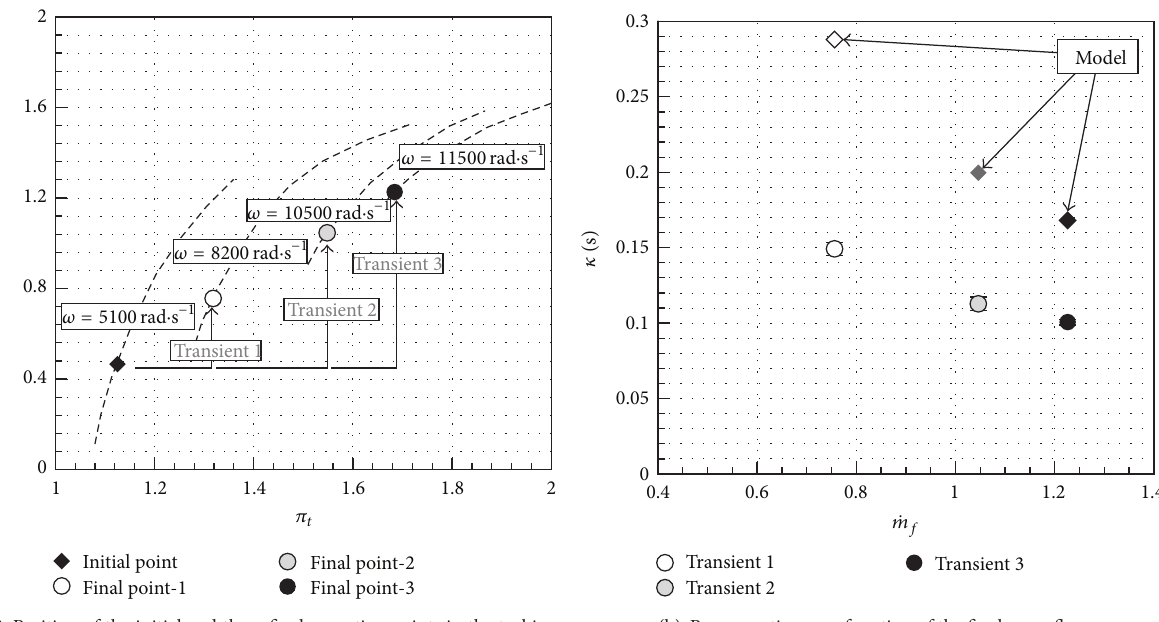
Figure 6: Modification of the gap in rotational speed during the transient for the stage 3ℎ